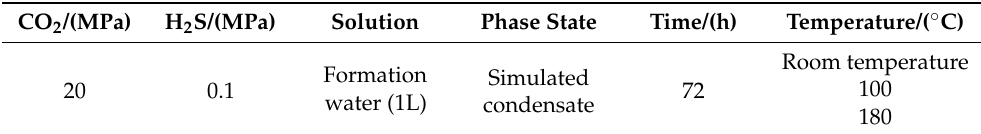
Table 2. Experimental schemes of HTHP corrosion experiment.